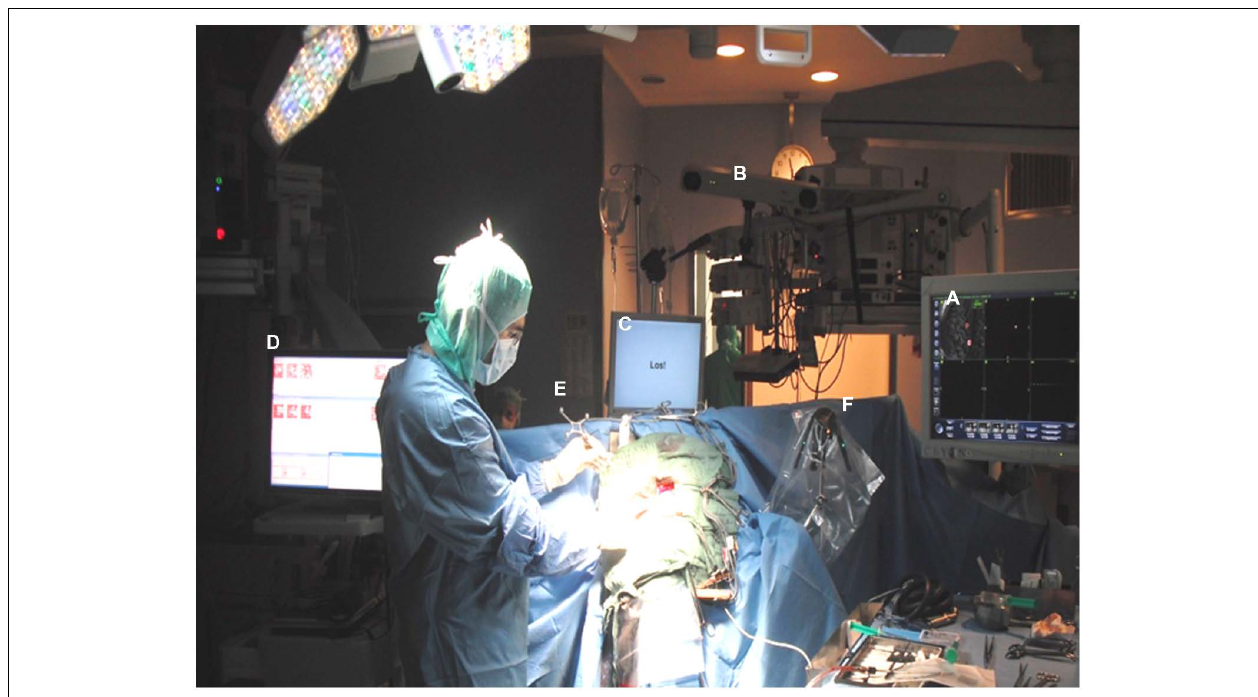
FIGURE 1 | Electrode grid implantation during awake surgery without direct exposure of the brain surface: craniotomy and initial epidural grid placement were performed with a neuronavigational approach based on preoperative magnetic resonance images (A) and intraoperative optical image-guidance (B). Grid positioning was refined applying online ECoG mapping (C) during cued phantom hand movements with auditory